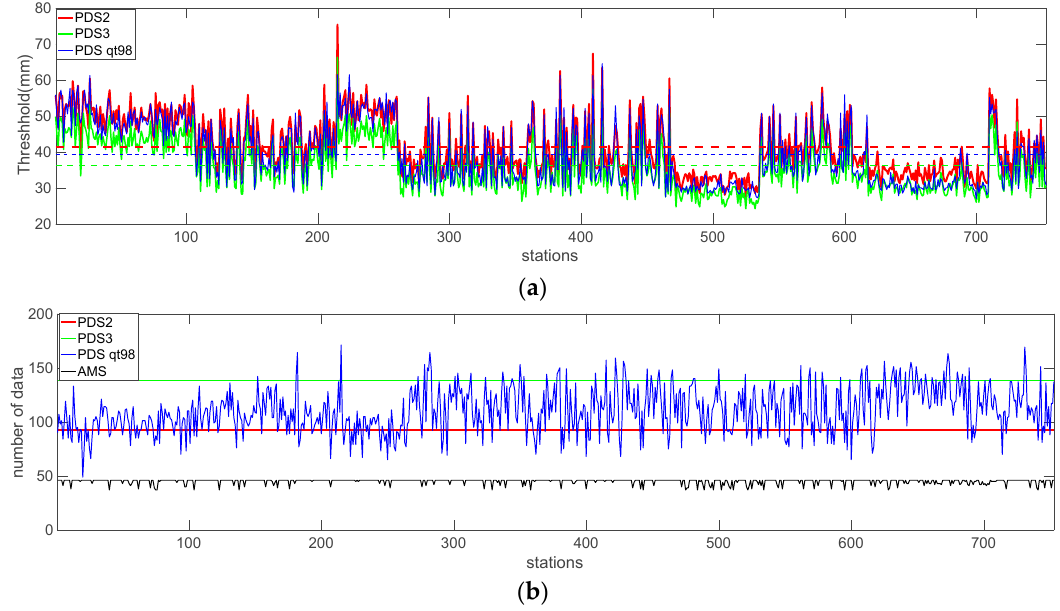
Figure 2. PDS thresholds ( a ) and length of data ( b ) used for PF analysis for each station. Red represents the results for PDS2, green for PDS3, blue for PDS qt98, and black for AMS.